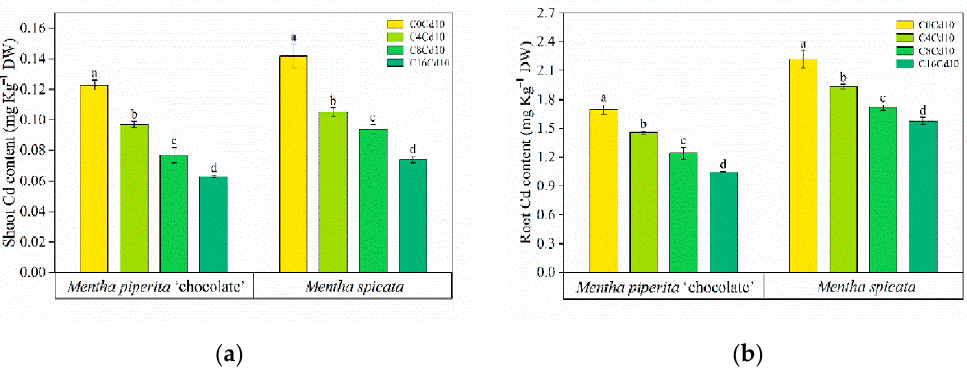
Figure 5. Effect of biochar addition on Cd content in shoot ( a ) and Cd content in root ( b ) of two mint species under Cd contamination. Error lines are standard deviations from the mean (n = 3), and different letters indicate significantly different values between treatments for the same plant, p < 0.05. DW, dry weight.